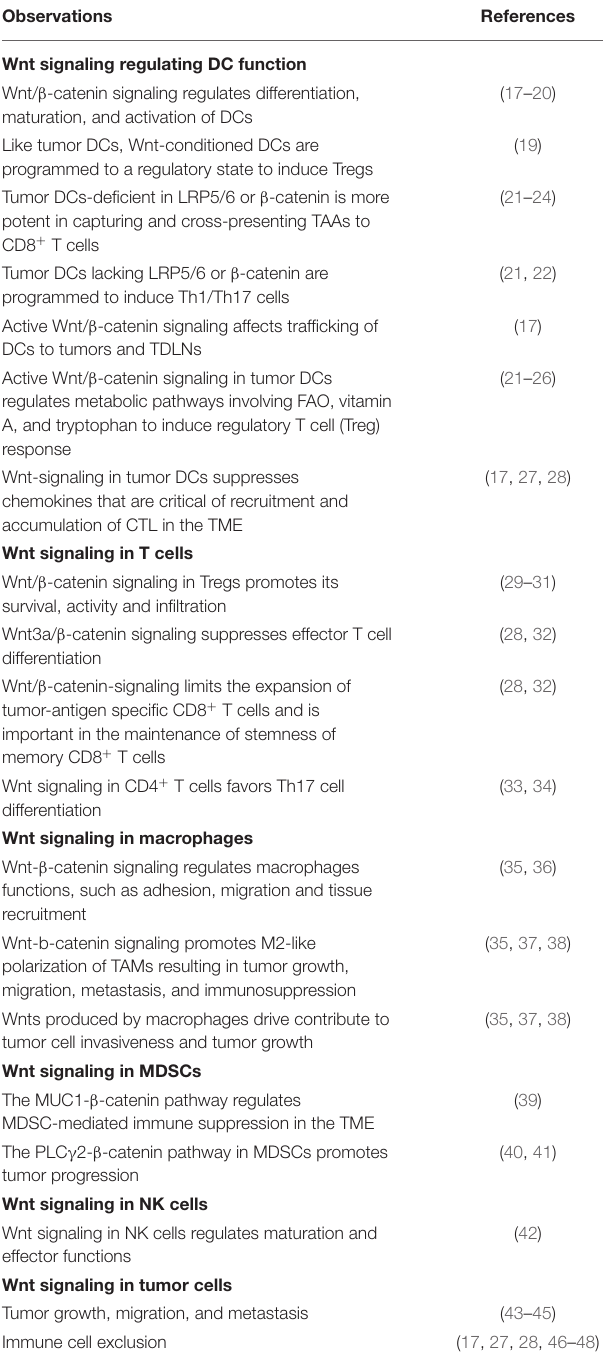
TABLE 1 | Evidence for involvement of the Wnt/ β -catenin pathway in regulating immune suppression and immune cell exclusion.